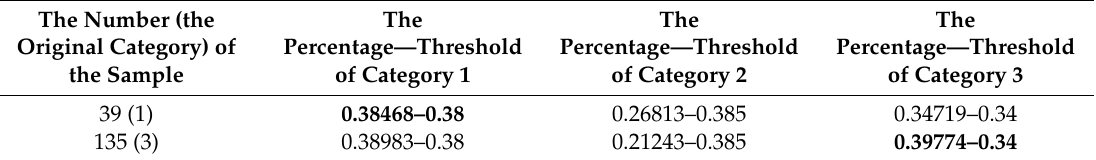
Table 5. The percentage of the two categories of Jindan10 corn seed